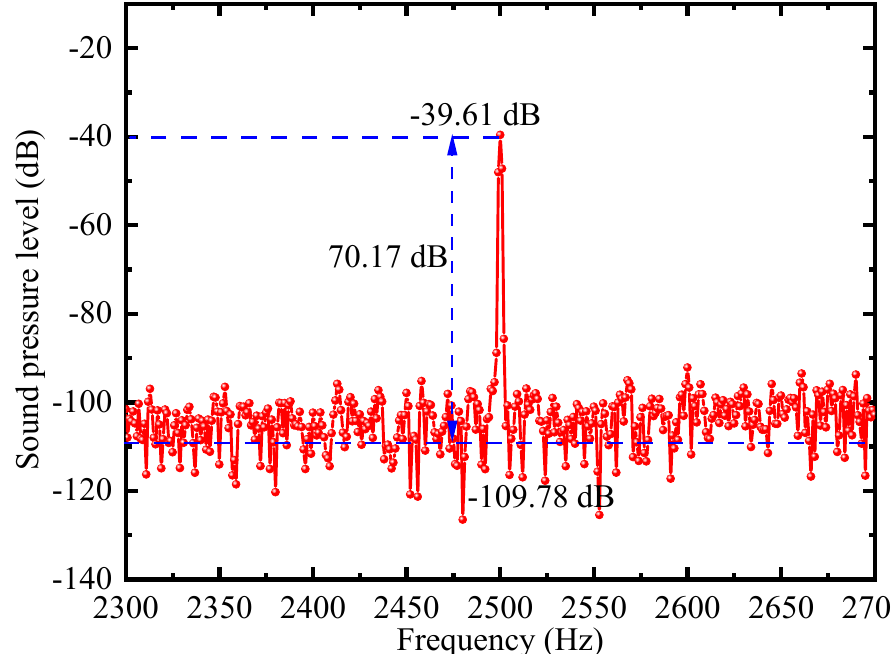
Figure 11. Spectrum of the FOM when a sound pressure of 0.003 Pa is applied at 2.5 kHz. Table 3. Performance of previously developed FOM, based on FPI.